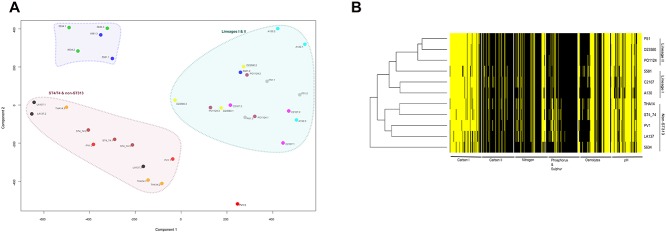
Metabolic profile of ST313 lineage I and lineage II isolates.
A. Principal component analyses of experiments on isolates and replicates used for 576 metabolic and physiological tests. The axes represent the two principal components (components 1 and 2) that explain the largest amounts of variation observed. Large coloured polygons represent identified clusters as labelled. Replicates of isolates sharing the same polygon colour are labelled with the name of isolates with number suffixes indicating replicate numbers. B. Representation of active (yellow) and non-active (black) wells. Varying shades of grey represent ambiguous (possibly active) results.